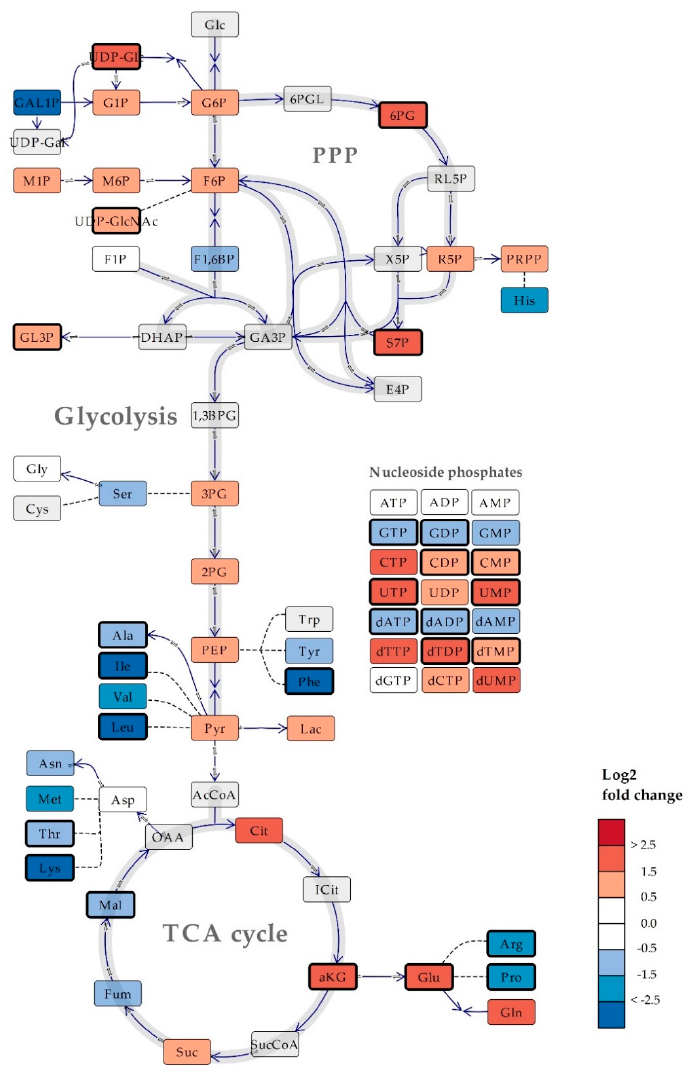
Figure 3. Simplified schematic overview of central carbon metabolism in Bacillus subtilis, with heat map of the log 2 fold change of average metabolite levels in cells cultured in mineral versus rich media. Bold lined rectangles indicate statistically significant metabolite levels (Two-tailed T-test, adjusted p -value (False Discovery Rate (FDR)) = 0.05). Levels of metabolites colored dark grey were < limit of quantification/detection. Metabolites colored light grey were not measured. Direct reactions are indicated by continuous lines, a series of reactions are indicated by dashed lines. Co-enzymes and -substrates are not included. TCA, tricarboxylic acid; PPP, pentose phosphate pathway; Glc, glucose; 6PGL, 6-phosphogluconic acid; RL5P, ribulose 5-phosphate; X5P, xylulose 5-phosphate; UDP-gal, UDP-galactose; DHAP, dihydroxyacetone phosphate; GA3P, glyceraldehyde 3-phosphate; 1,3BPG, 1,3-bisphosphoclyceric acid; AcCoA, Acetyl-CoA; SucCoA, Succinyl-CoA; OAA, oxaloacetic acid. Abbreviations for quantified metabolites are listed in Table